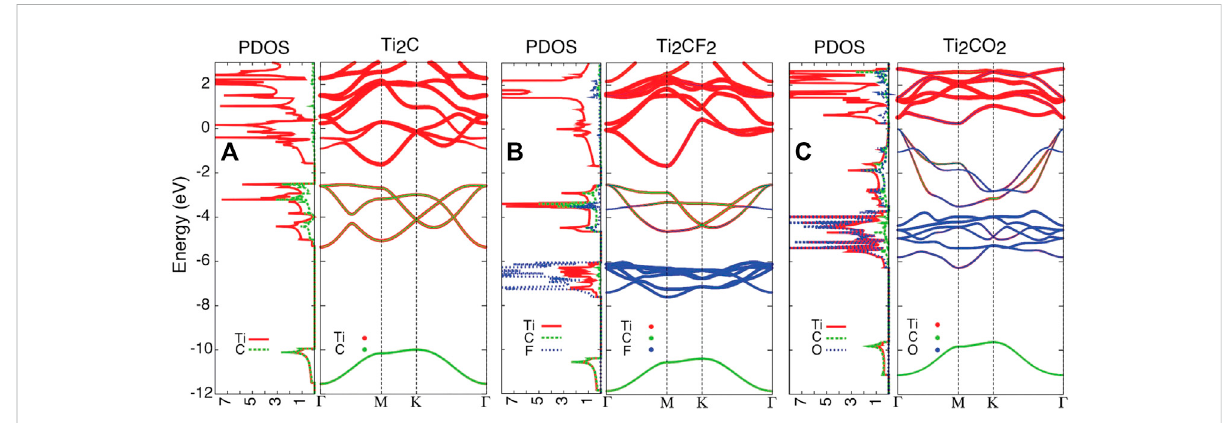
FIGURE 5 Projecteddensityofstates[PDOS(statespereVpercell)]andprojectedbandstructuresfor (A) Ti 2 C, (B) Ti 2 CF 2 ,and (C) Ti 2 CO 2 .TheFermienergy is located at zero energy, Reproduced with permission from Khazaei et al. (2017), ©Royal Society of